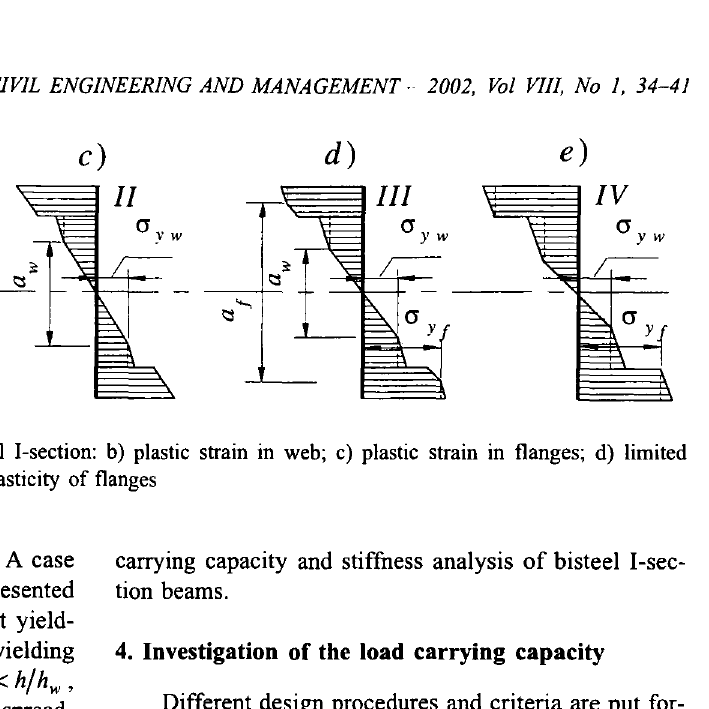
Fig ~· Pen~tration .of plastic strain in the bisteel !-section: b) plastic strain in web; c) plastic strain in flanges; d) limited plastic stram both m flanges and web; e) full plasticity of